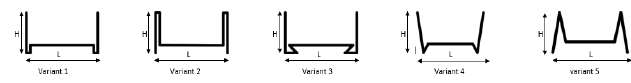
Figure 3: Variants 1 to 5 of creased and bended cardboard for general purpose suspension